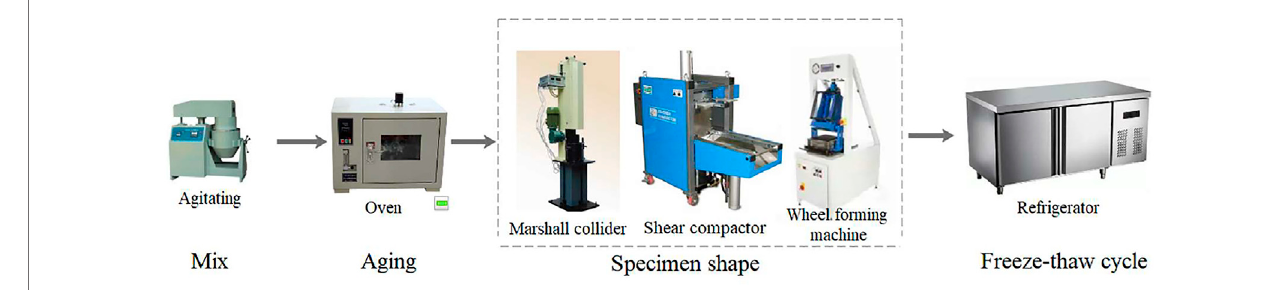
FIGURE 3 | Preparation process of the asphalt mixture.